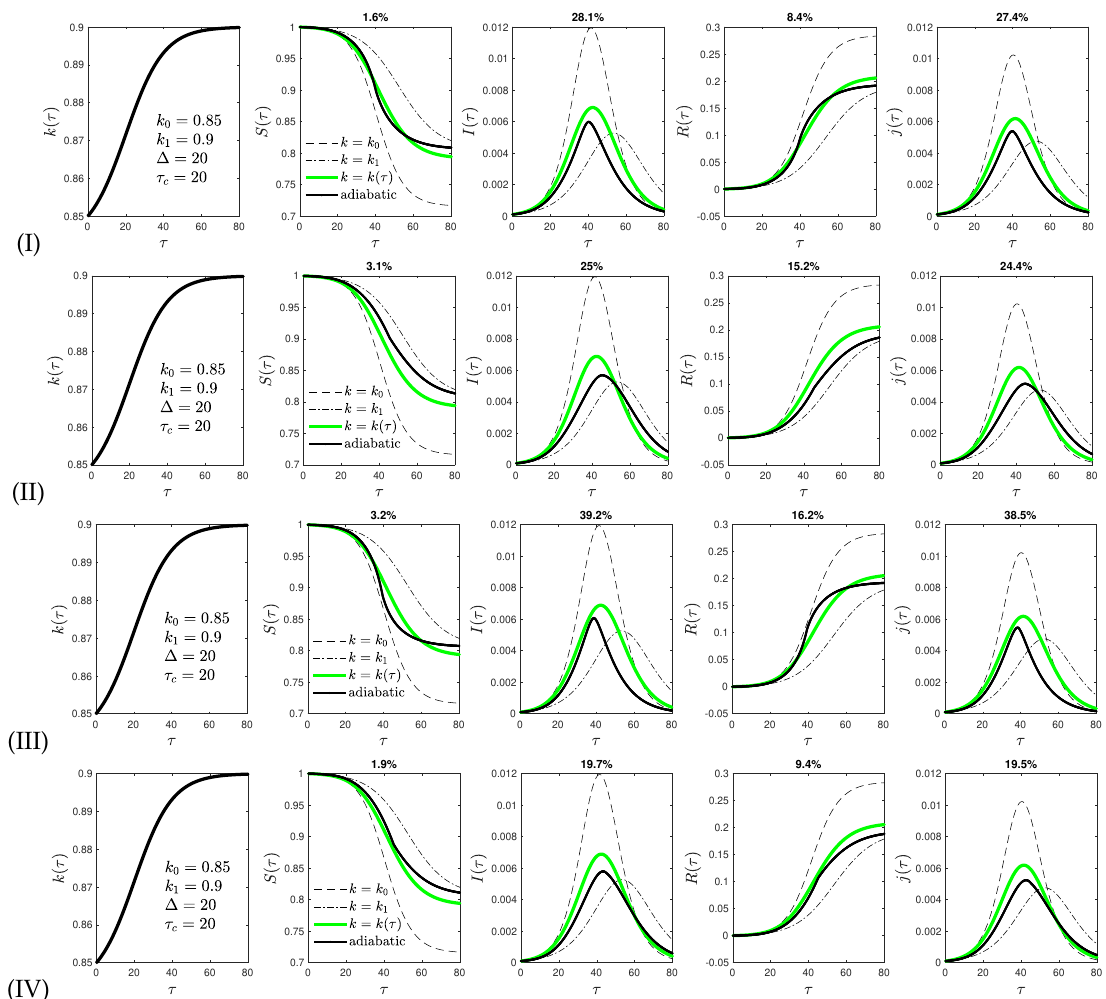
Figure 5. Same as Figure 2 but with another set of the parameters ( k 0 = 0.85, k 1 = 0.9, ∆ = 20, and τ c = 20) of the ratio k ( τ )